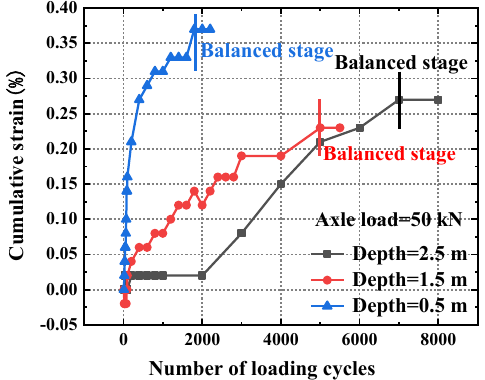
Figure 9. Cumulative strain under 50 kN axial load.